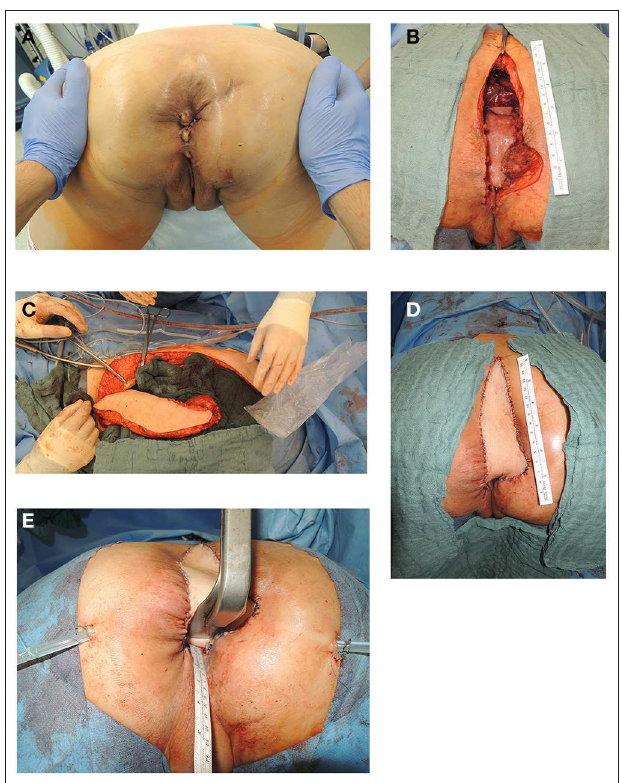
FIGURE 3 | (A) Anatomic site of relapsing lower rectal cancer following neoadjuvant radiochemotherapy in a 55 years old female patient (patient in prone position). (B) Resectional defect with missing posterior vaginal wall and pelvic floor defect following radical resection of relapsing rectal cancer following cylindrical resection (patient in prone position). (C) Vertical recztus abdominis myocutaneous flap harvested from right abdominal wall. (D) Skin island of VRAM flap utilized to reconstruct posterior vaginal wall and sacral defect after coccyectomy to cover os sacrum and to close resectional skin defect (patient in prone position). (E) Aspect of posterior vaginal wall reconstruction and sacral defect coverage with skin island of transpelvic VRAM flap (patient in prone position).